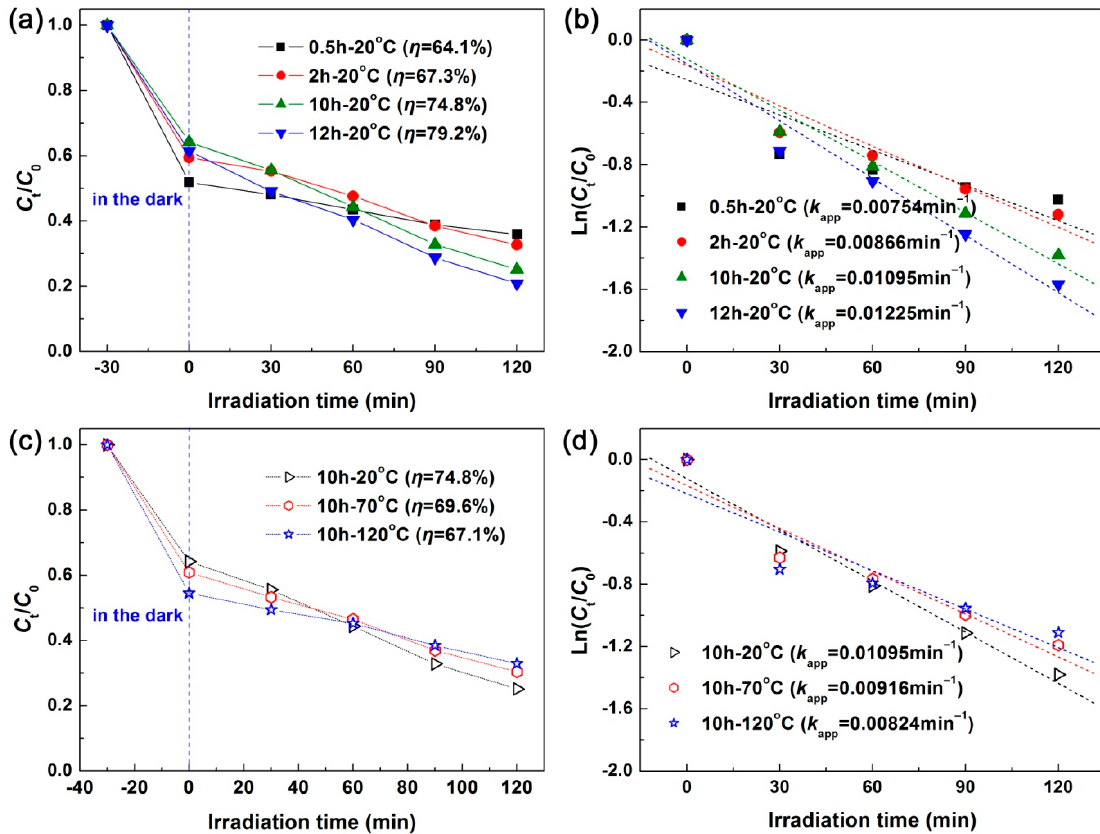
Figure 4. ( a , b ) Photodegradation curves of RhB and corresponding degradation kinetic plots over the CuS samples synthesized at 20 °C with different reaction times, respectively. ( c , d ) Photodegradation curves of RhB and corresponding degradation kinetic plots over the CuS samples synthesized at different reaction temperatures for 10 h, respectively.